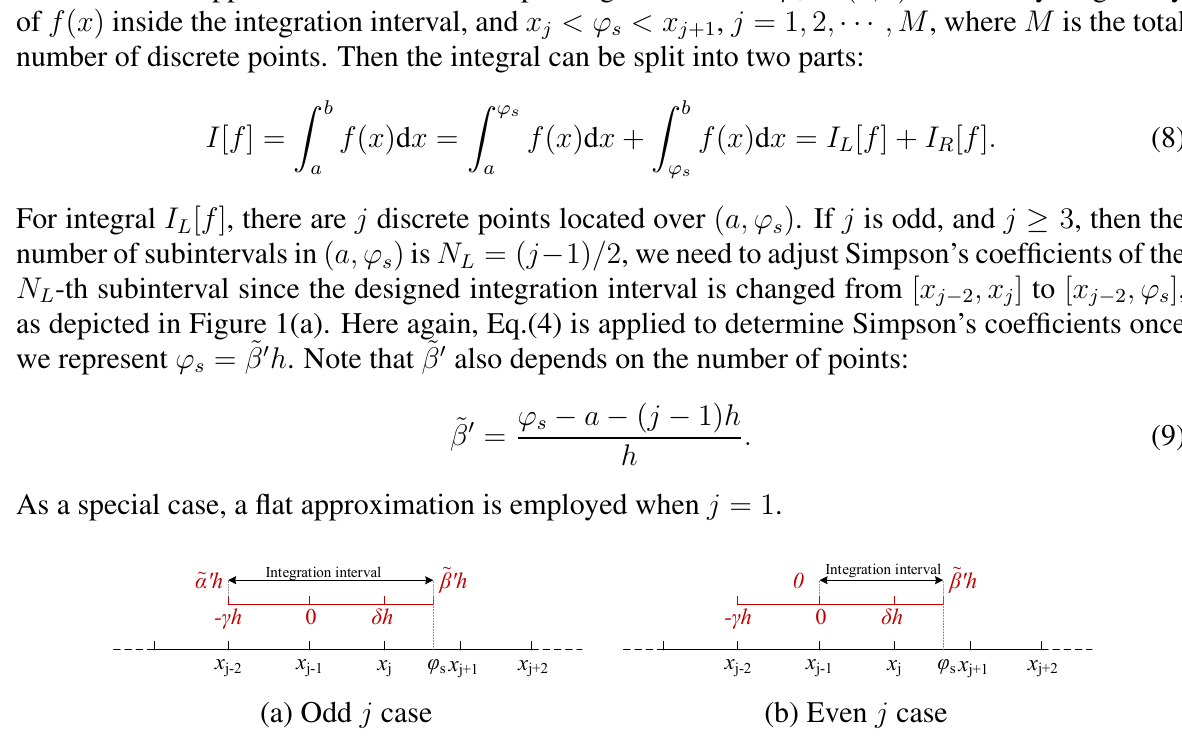
Figure 1: Two cases considered in adaptive coefficient